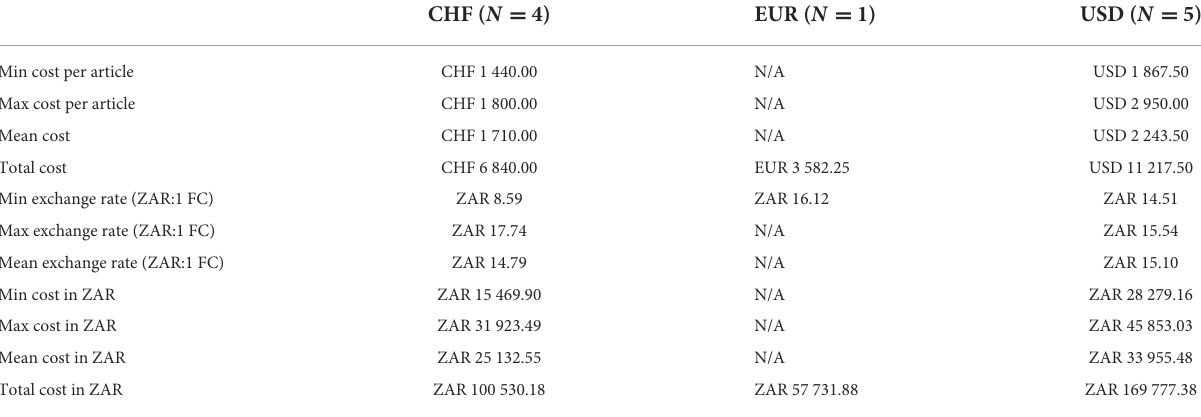
TABLE 1 A summary of the APCs paid for 10 published articles during